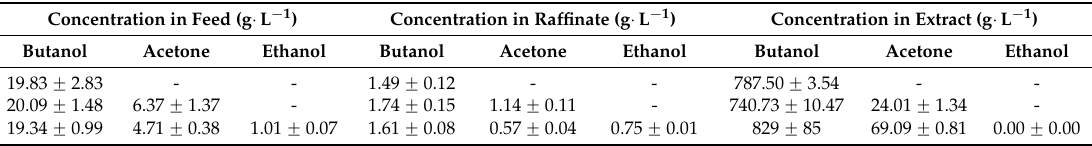
Table 4. Concentration of butanol, acetone and ethanol (g ¨ L ´ 1 ) in the feed, raffinate and extract samples collected after the continuous cycle at 35 ˝ C and 10.34